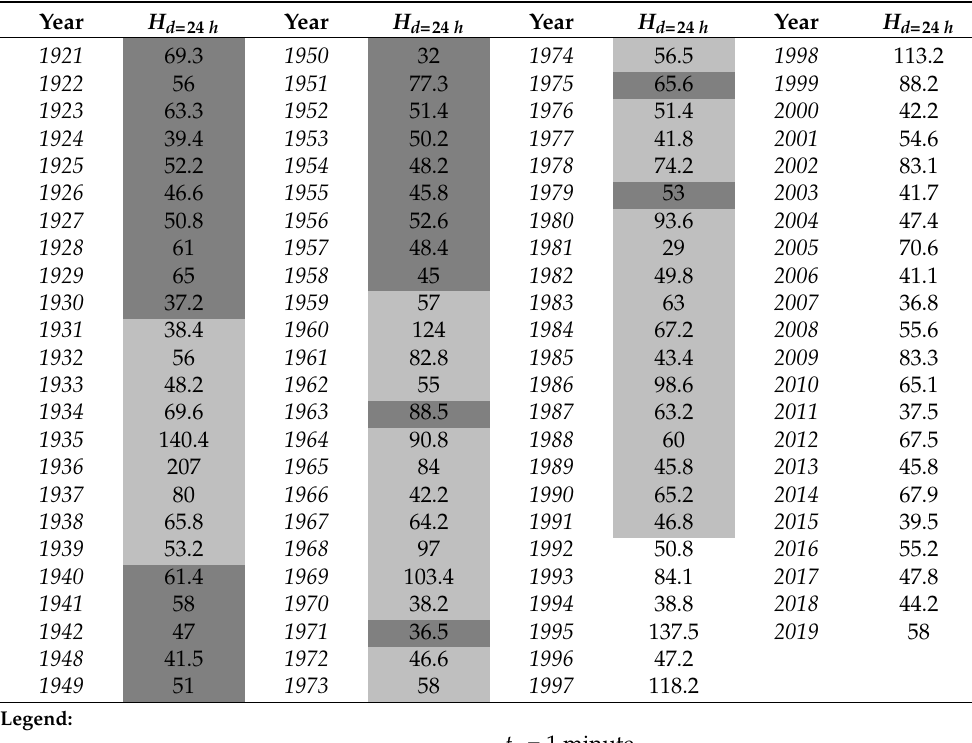
Table 3. Annual maximum rainfall depths (in mm) for duration ( d ) equal to 24 h, H d= 24 h , derived from data characterized by different aggregation times, t a . Todi rain gauge